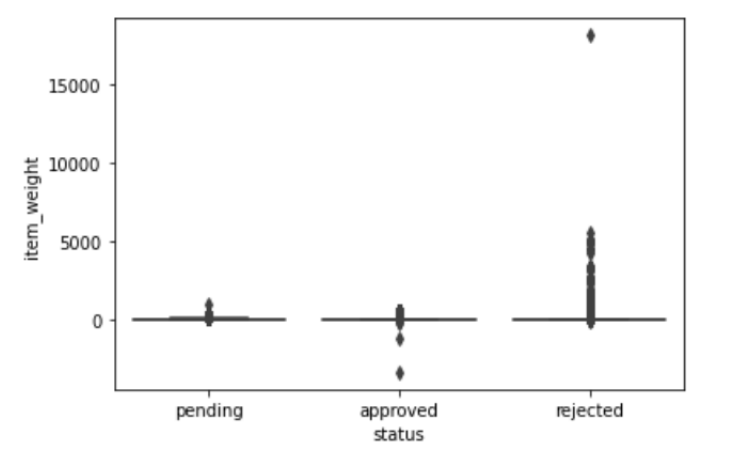
Figure 5. Relationship between target variable and item